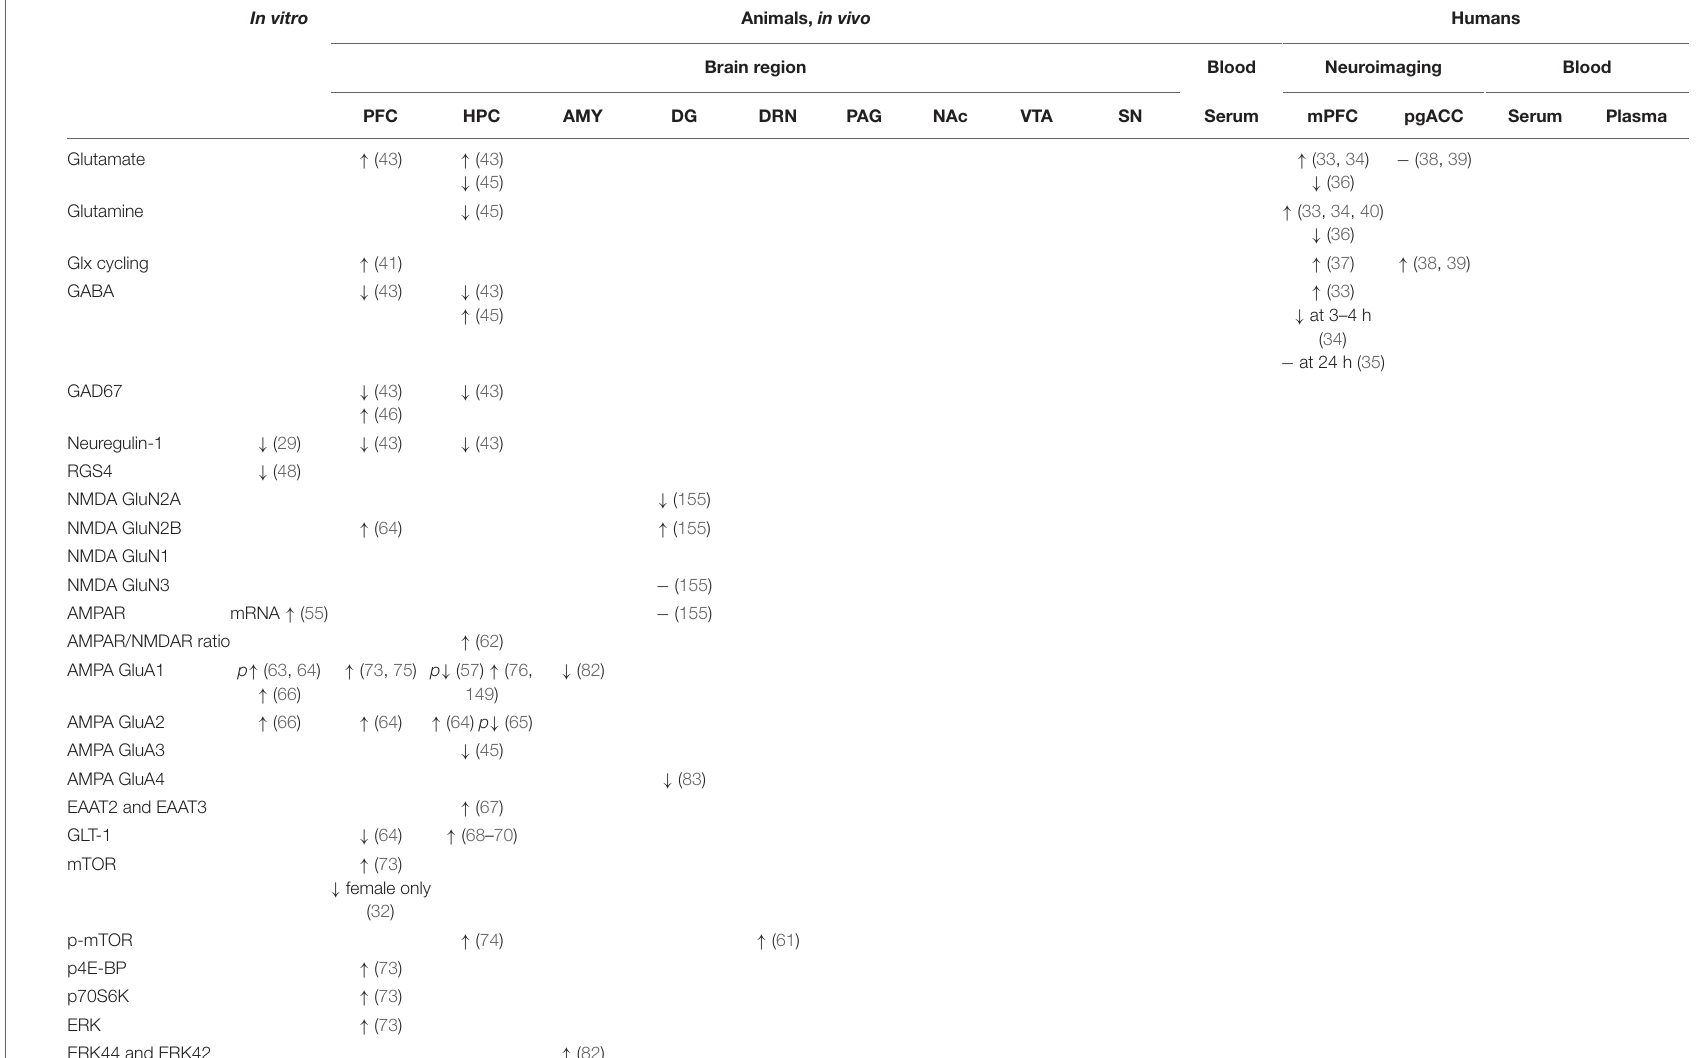
TABLE 1 | Molecular changes observed after ketamine administration in preclinical (cell cultures, animals), and clinical studies. In